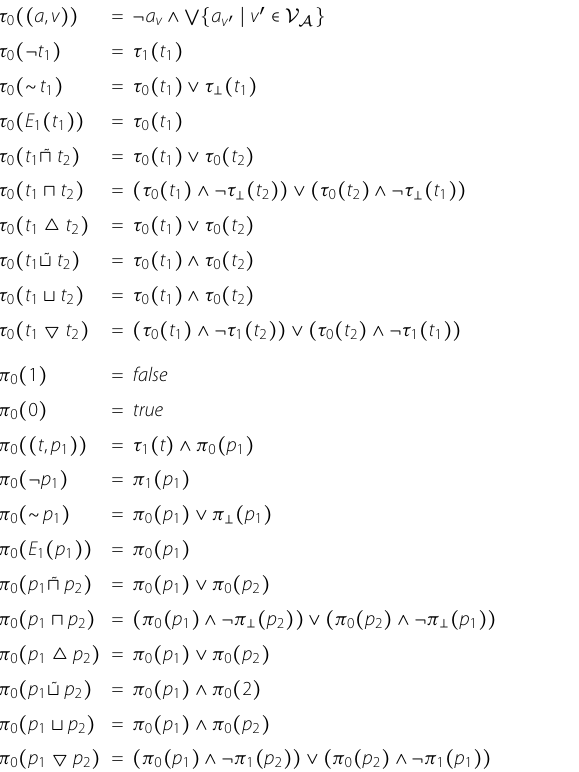
Table 2 Transformation rules for τ (for targets) and π (for policies) for decision 1